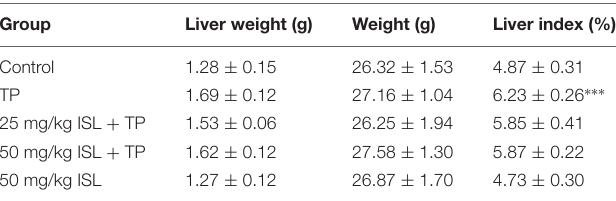
while combined ISL treatment induced the expressions of total,